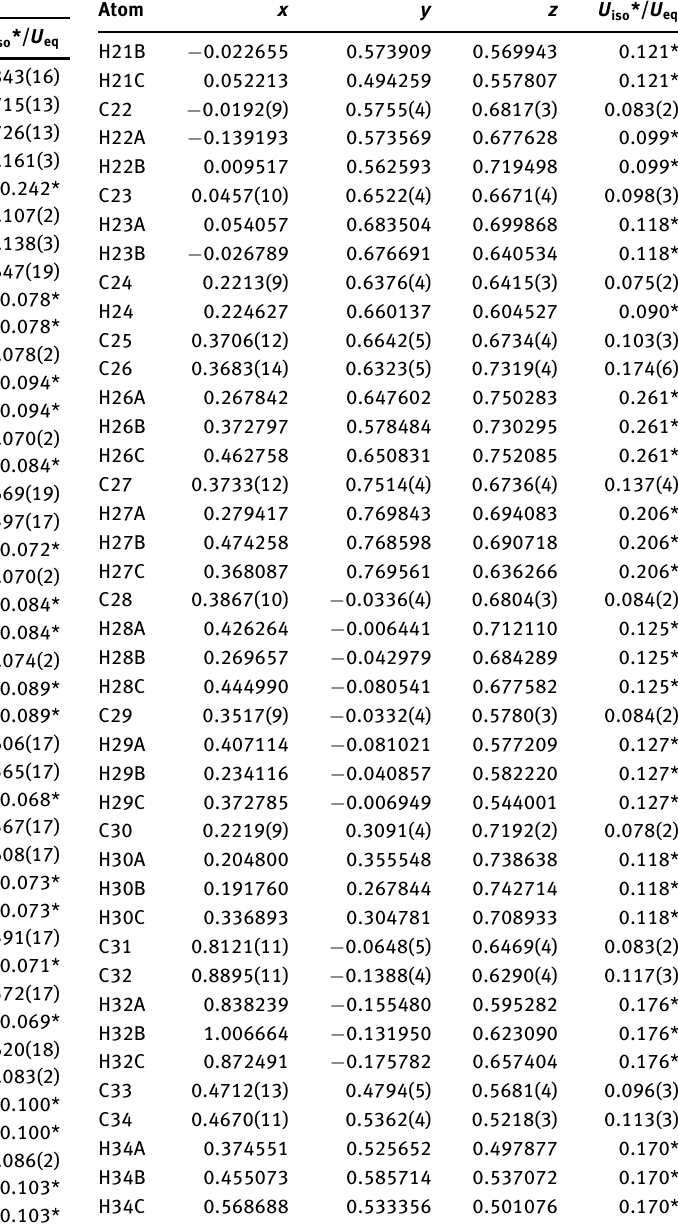
Table 2: Fractional atomic coordinates and isotropic or equivalent isotropic displacement parameters (Å 2